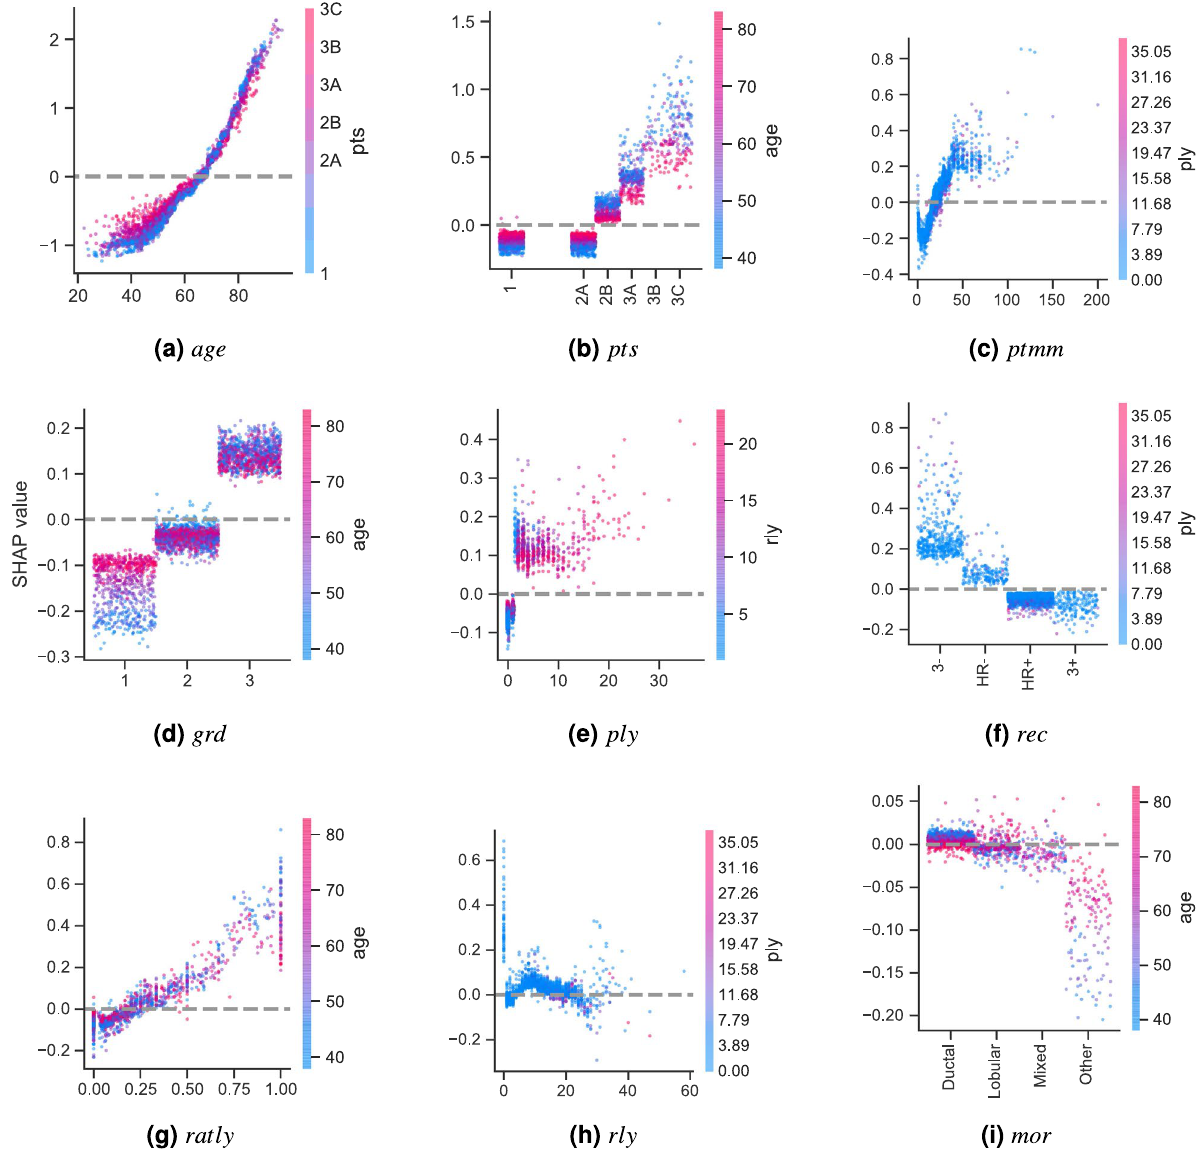
Figure 5. SHAP feature dependence plots of the XGB model showing the largest interaction effect for each feature. In the case of categorical variables, artificial jitter was added along the x axis to better show the density of the points. In this case, the scale of the y axis is not the same for all plots in order to better appreciate the interaction